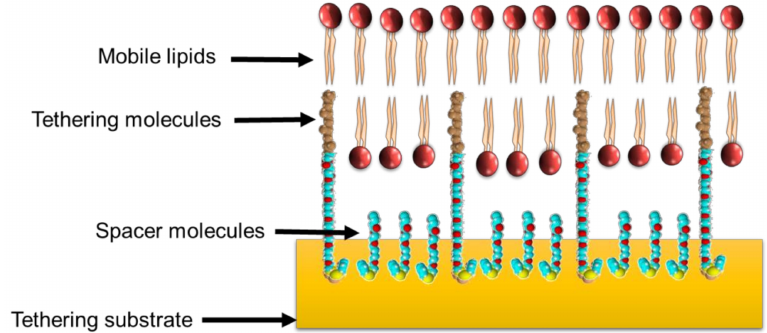
Figure 1. A basic tethered bilayer lipid membrane architecture. The use of membrane-tethering molecules and spacer molecules creates a reservoir between the membrane and the substrate to provide space for the transport of ions and the insertion of extended membrane-bound peptides or proteins.